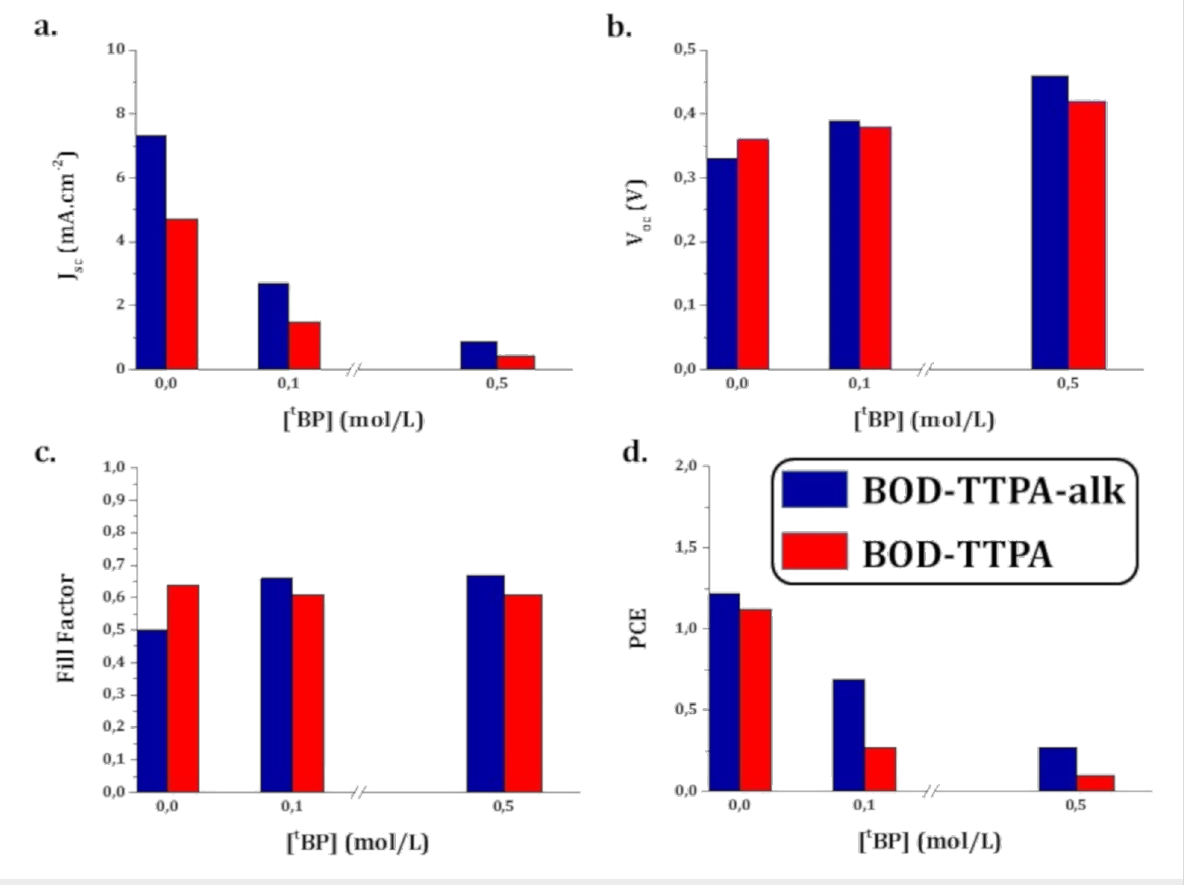
Figure 7: Photovoltaic parameters evolution with the increasing concentration of t BP in the electrolyte.